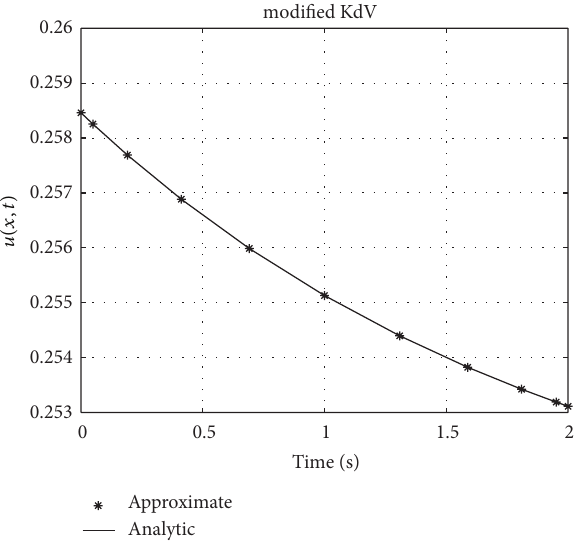
Figure 4: Burgers-Huxley equation analytical solution graph.